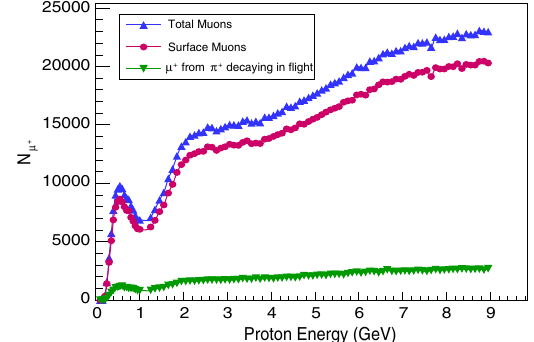
FIG. 14. Variation of muon yield with proton energy at higher energies.